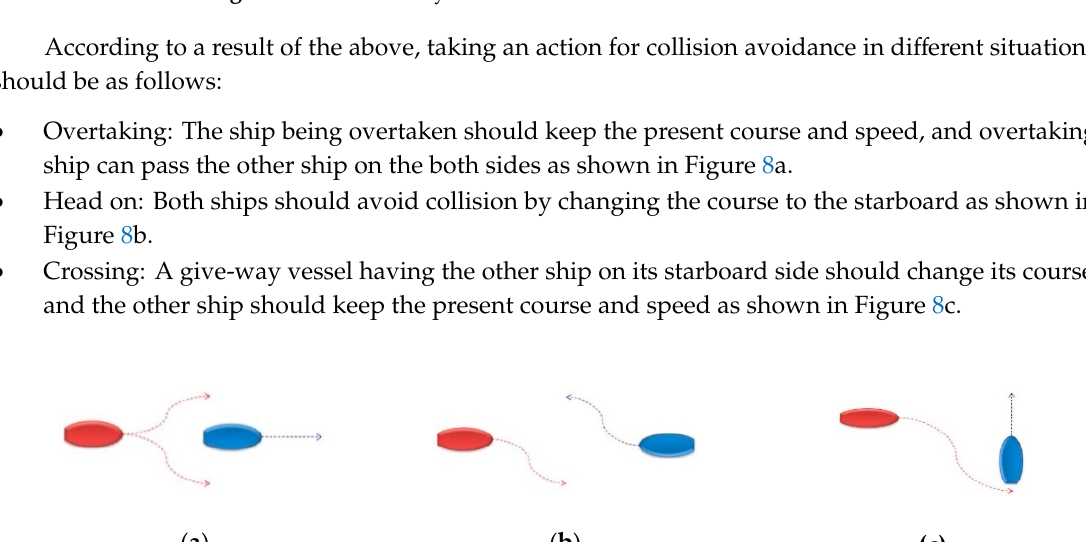
Figure 7. The boundary between the different COLREGs situations.